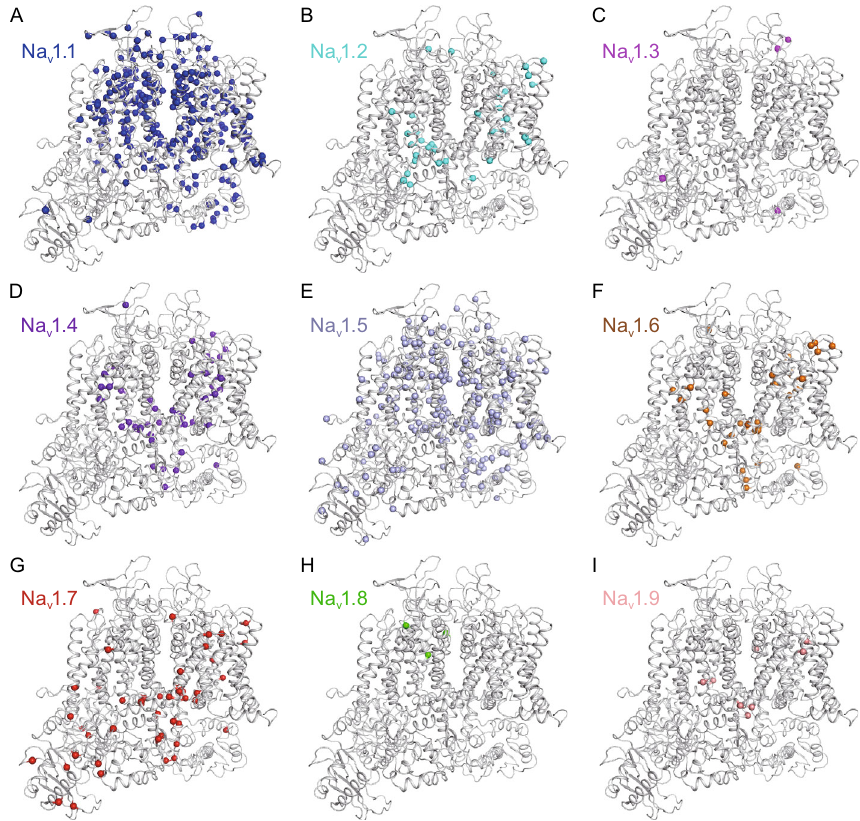
Figure 3. Mapping of Na v channel disease-related mutations onto the Na v 1.7 structure model. The Na v 1.7 channel is shown in cartoon from the intra-membrane view. The C α atoms of the disease-related amino acids are shown in spheres. Mapped mutations from nine Na v sodium channels to the Na v 1.7 structure model are differentiated by distinct colors, Na v 1.1 (A, blue), Na v 1.2 (B, cyan), Na v 1.3 (C, magenta), Na v 1.4 (D, purple blue), Na v 1.5 (E, pale cyan), Na v 1.6 (F, orange), Na v 1.7 (G, red), Na v 1.8 (H, green),